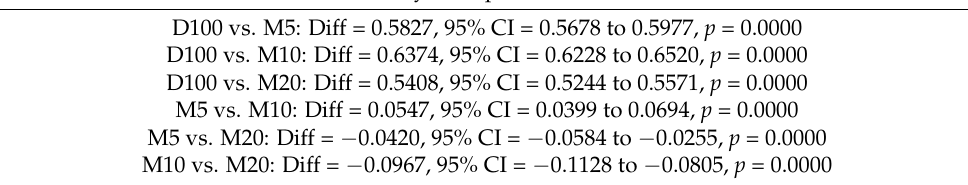
Table 10. Results of ANOVA with Tukey HSD post hoc test for NO X at the measurement point 3. ANOVA Degrees of α = 0.05 Sum of Squares Variance F Freedom Between groups 82.6574 3 27.5525 5240.5733 Within groups 6.1776 1175 0.0053